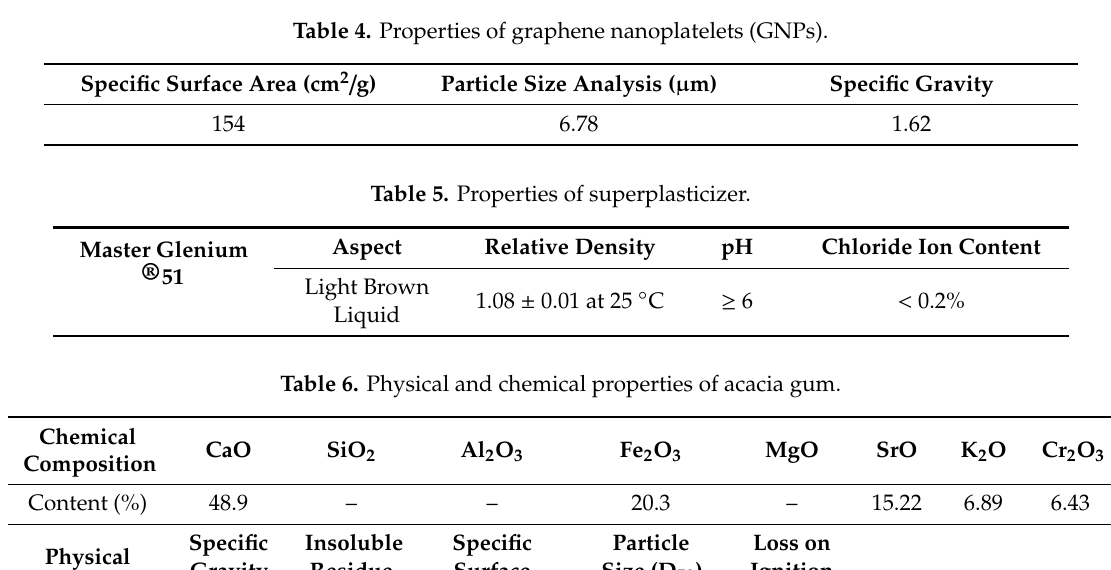
Figure 2. Carbon nanotubes (CNTs) agglomeration without surfactant.